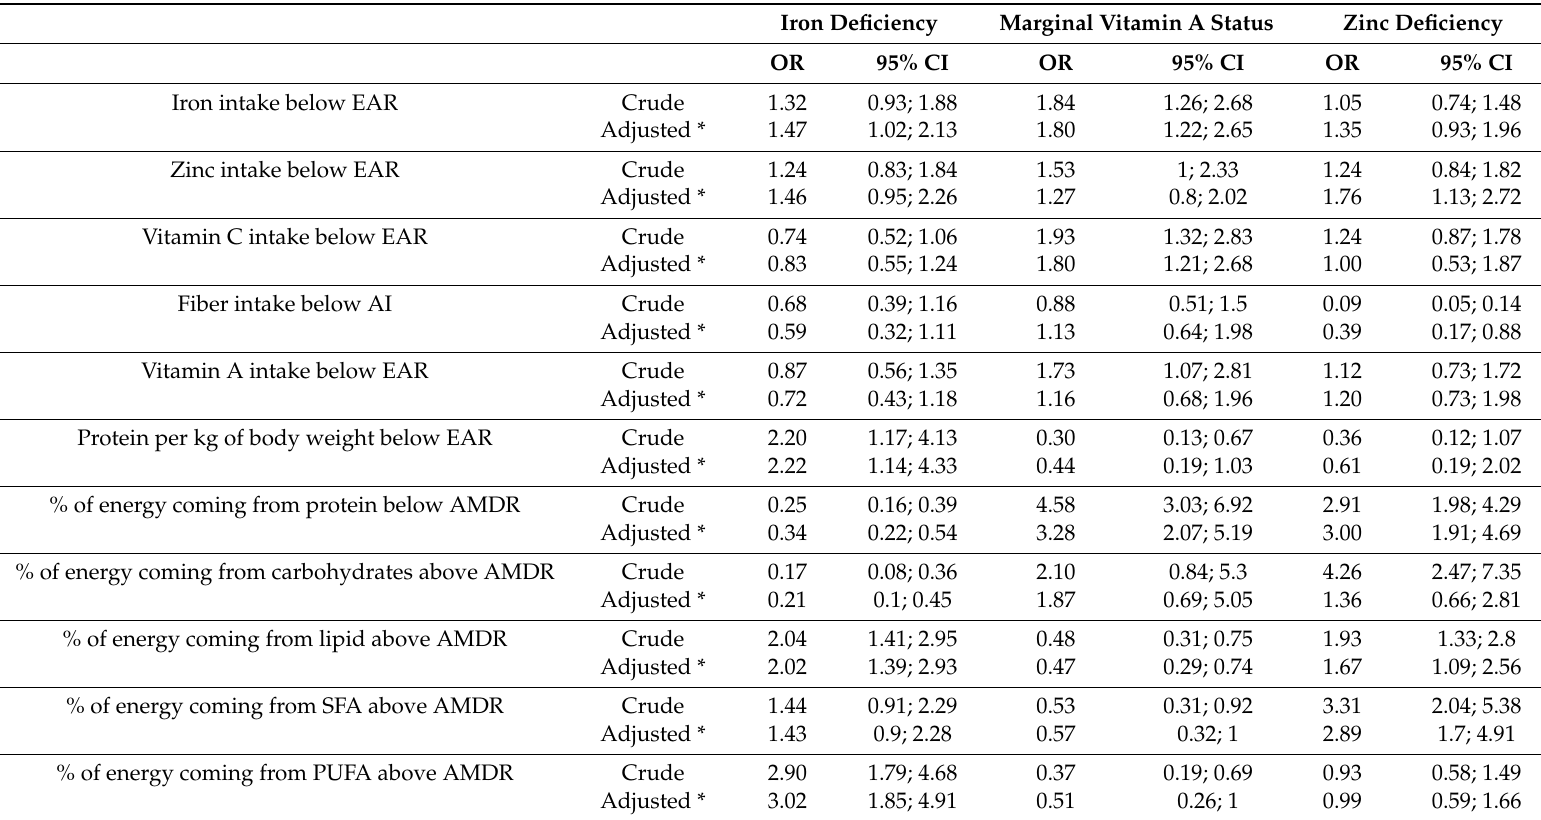
Table 3. Crude and age-gender adjusted odds ratios (OR) and confidence interval (CI) for insufficient nutrient intake associated with micronutrient